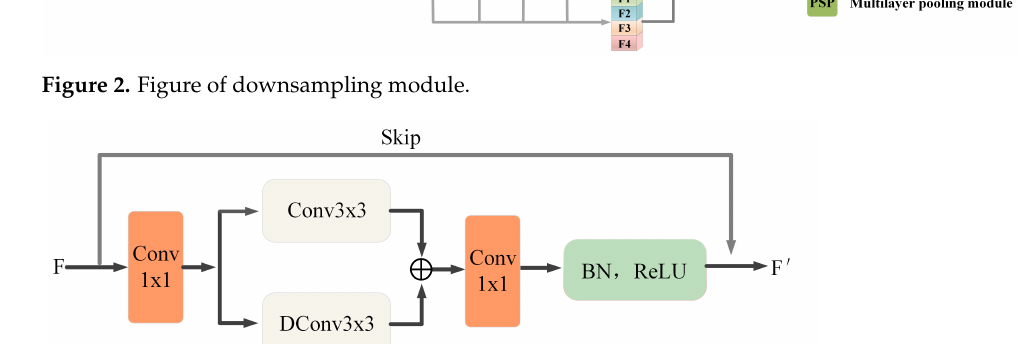
Figure 3. Feature extraction module.